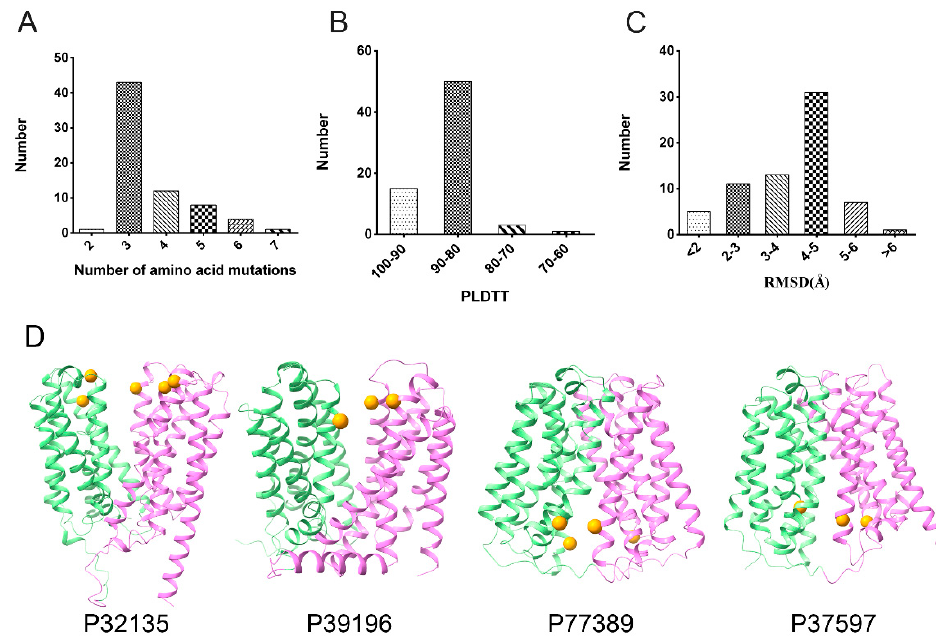
Figure 2. Statistics of 69 MFS members in E. coli . ( A ) The number of mutant residues. ( B ) The pLDDT score. ( C ) The C α RMSD between two conformations. ( D ) The mutant structures were predicted by AlphaFold2. The N-terminal domain was colored pale green, and the C-terminal domain was colored violet. The mutation sites were represented by orange spheres.